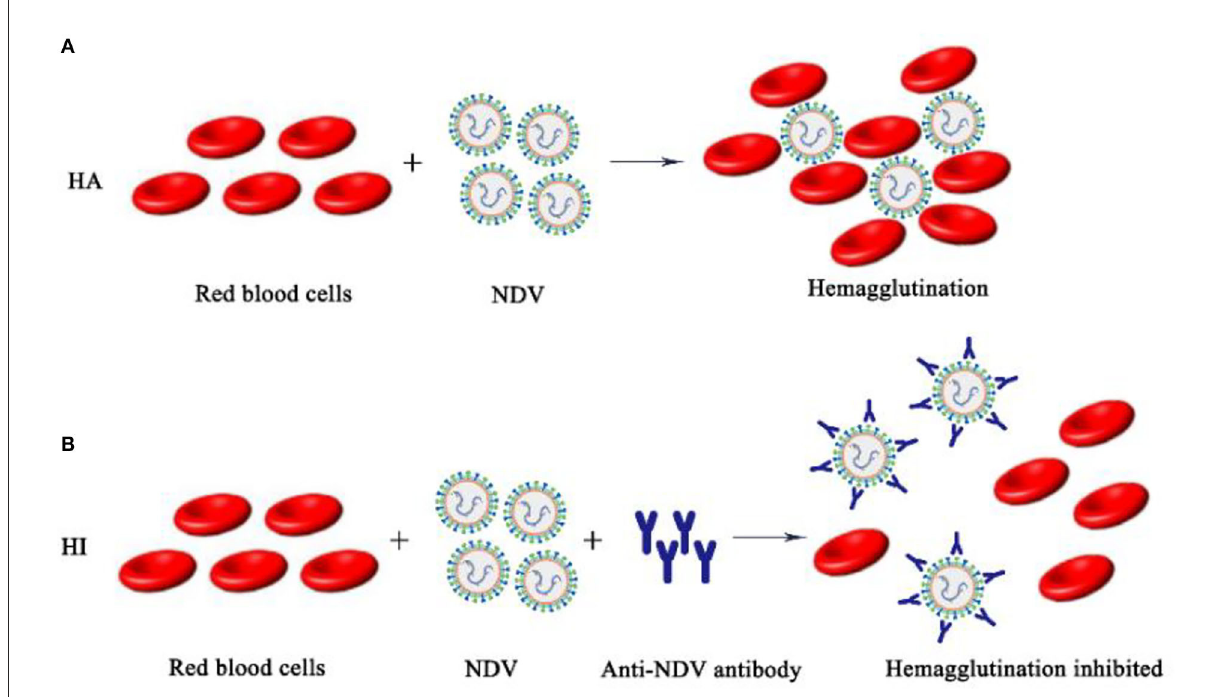
FIGURE4 Schematic diagram of NDV HA-HI. (A) NDV hemagglutination mechanism; (B) NDV hemagglutination inhibition